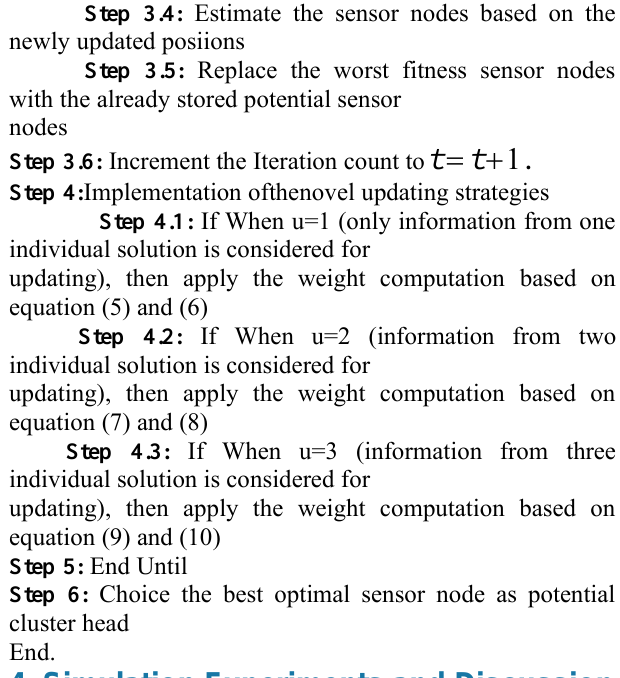
Table 1. Simulation step used for implementing the proposed NIUS-HEHOA-OCHS